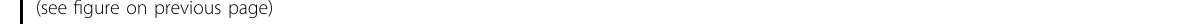
Fig. 4 ALDH1A3 alters the phenotypes of CRC cells. a Downregulation of ALDH1A3 by transfection of siRNAs was con fi rmed by Western blot in HCT116 and LoVo cells. b Upregulation of ALDH1A3 by transfection of ALDH1A3 plasmids was con fi rmed by Western blot in DLD1 and RKO cells. c , d Knockdown of ALDH1A3 signi fi cantly inhibited proliferation of HCT116 and LoVo by CCK8 (c) and colony formation assay ( d ). e , f Overexpression of ALDH1A3 signi fi cantly increased proliferation of DLD1 and RKO by CCK8 ( e ) and colony formation assay ( f ), and could be partially counteracted by CuET treatment and ALDH1A3 knockdown, respectively. g , h Flow cytometry showed that knockdown of ALDH1A3 promoted cell apoptosis ( g ), while overexpression of ALDH1A3 inhibited apoptosis and was partially counteracted by 1.0 μ M CuET treatment ( h ). Data in c – h are presented as the mean ± SD of three independent experiments, * p < 0.05, ** p < 0.01, *** p < 0.001, **** p <